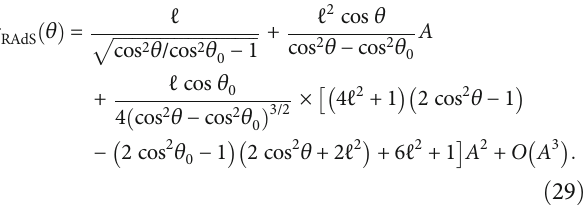
Figure 2: The holographic entanglement entropy for the charged accelerating AdS Black hole with respect to the acceleration parameter A . Here, we take q = 0 : 01 , m = 0 : 1 , ℓ = 1 , and θ The holographic entanglement entropy decreases with increasing acceleration exhibiting behaviour similar to the one observed in relativistic quantum information studies [51,